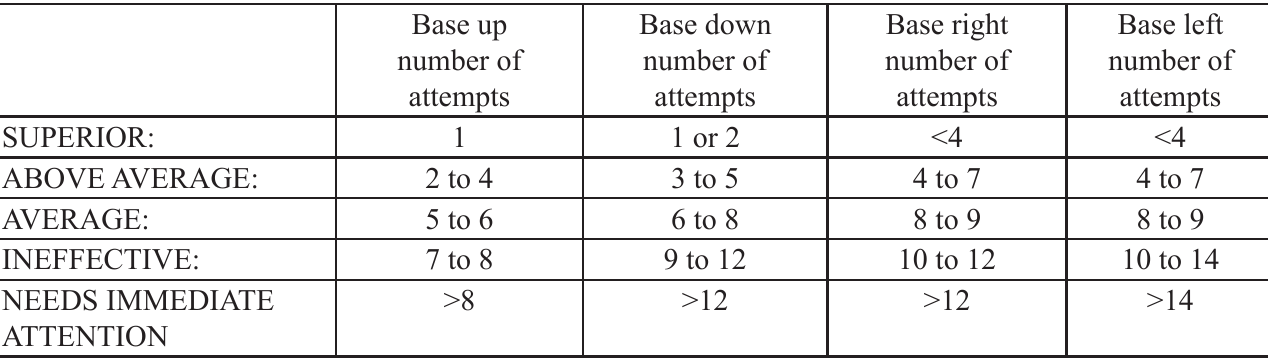
Table 12 : The norms obtained for Visual Adjustability with the use of 20 prism dioptres lenses in the base up, base down, base left and base right